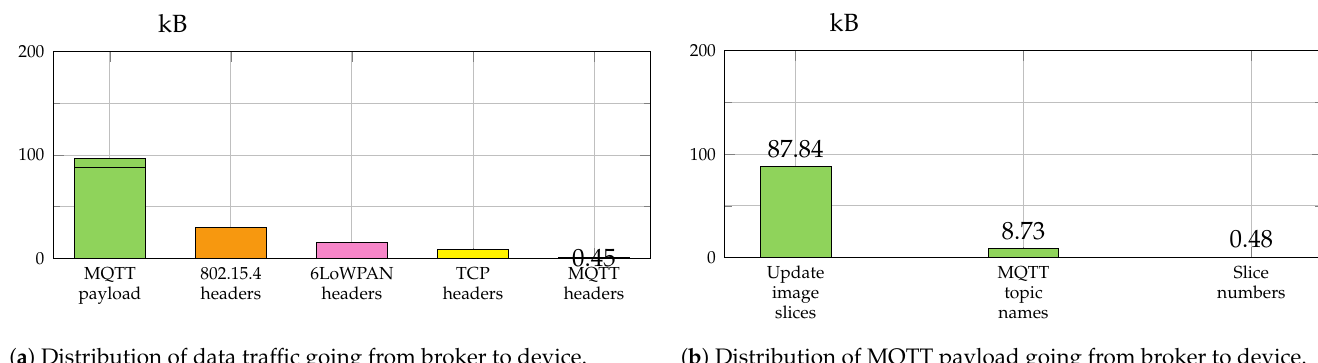
Figure 8. Analysis of the network traffic captured during the transmission of an update image file with a size of 87.8 kB using a slice size of 600